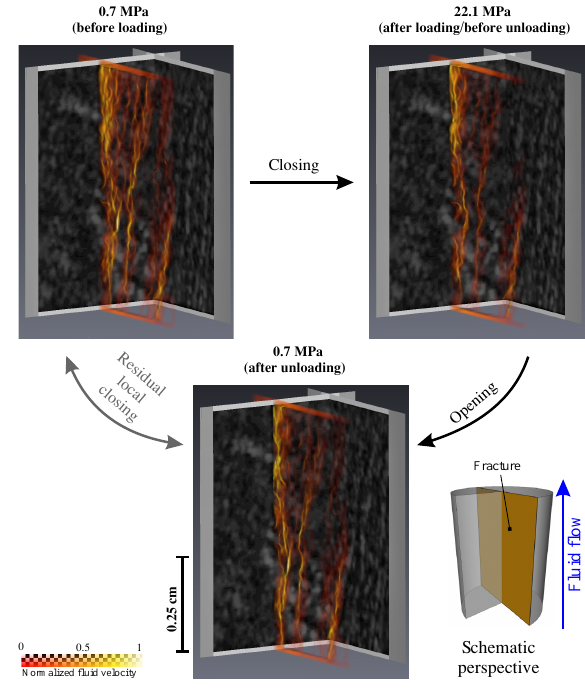
Figure 5. Changes in 3-D fluid flow only along the fracture plane due to closing during loading conditions (from 0.7 to 22.1MPa) and due to reopening caused by unloading conditions (from 22.1 to 0.7MPa) by applying forward modeling with an explicite finite- volume method solving the Navier–Stokes–Brinkman equation. Fluid flow is visualized by fluid velocity per voxel normalized by the maximum fluid velocity at the given pressure stage. Fluid ve- locity increases from red to yellow. Velocity fields of the initial and residual pressure stage (0.7MPa) indicate permanent local closings along the fracture. A schematic perspective is included for better 3-D